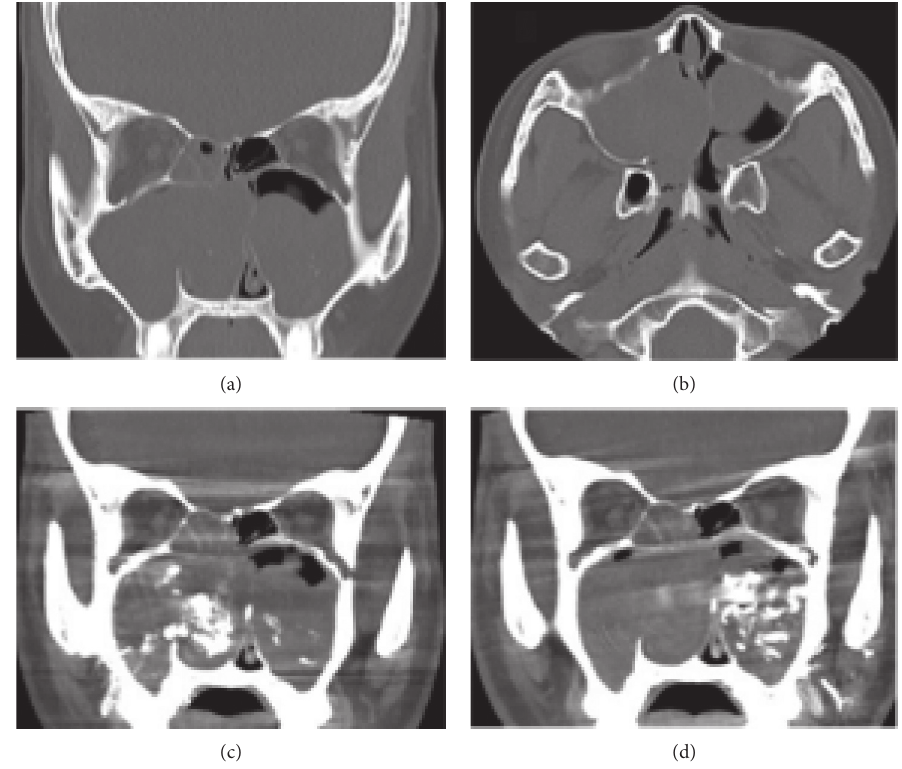
Figure 1: Noncontrast computed tomography and computed tomography angiography images. Preoperative (a) coronal and (b) axial noncontrast computed tomography shows a soft tissue mass filled the bilateral nasal cavities and maxillary sinuses without bony destruction. Computed tomography angiography shows that (c) the main feeder of right-side tumor was greater palatine artery and (d) the other side was infraorbital artery.